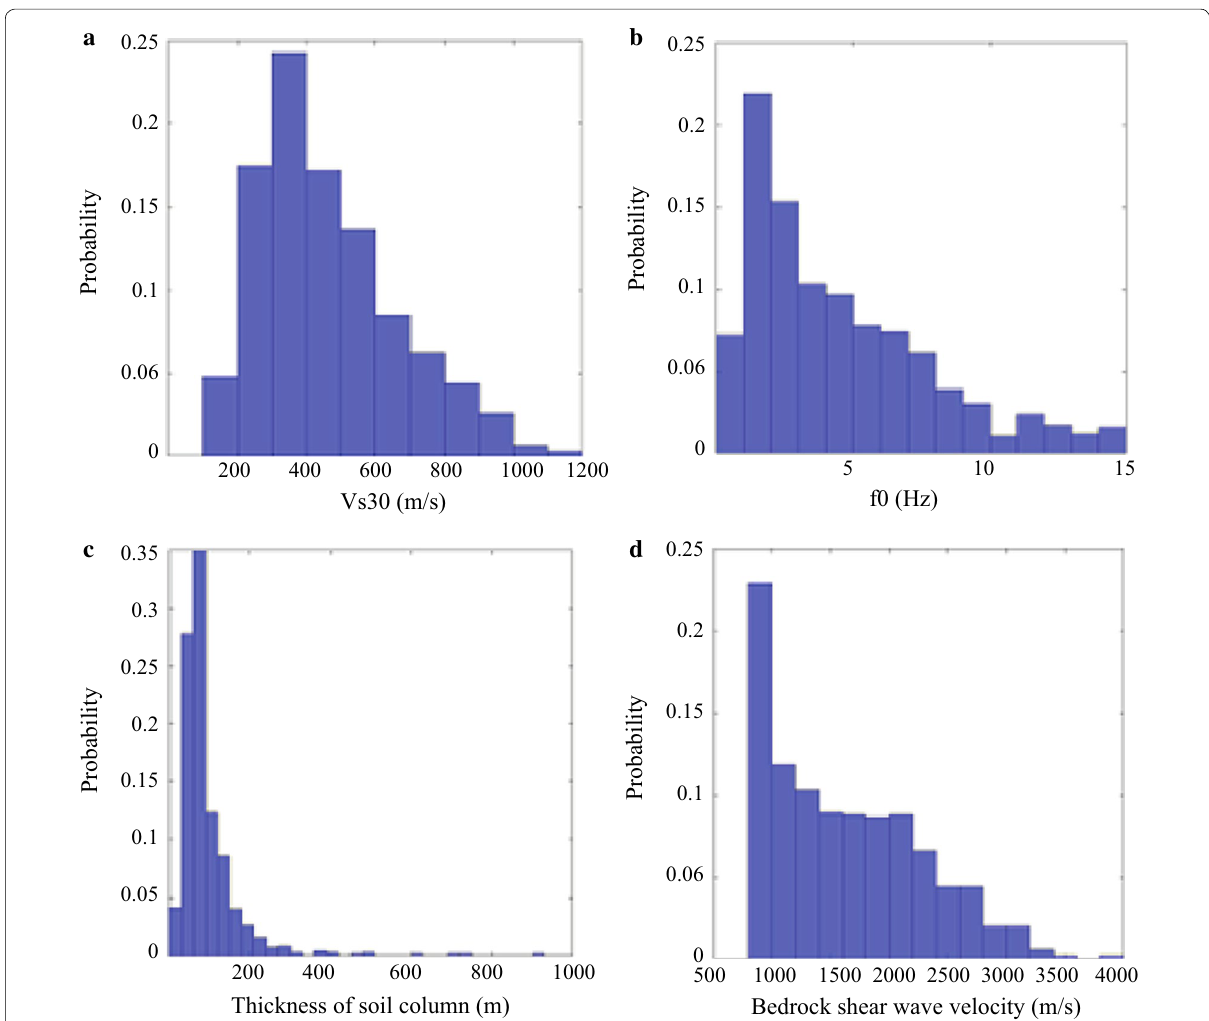
Fig. 12 Overview of main site characteristics for the considered soil profiles: distribution of a V s30 values, b f 0 values, c total thickness values and d bedrock shear wave